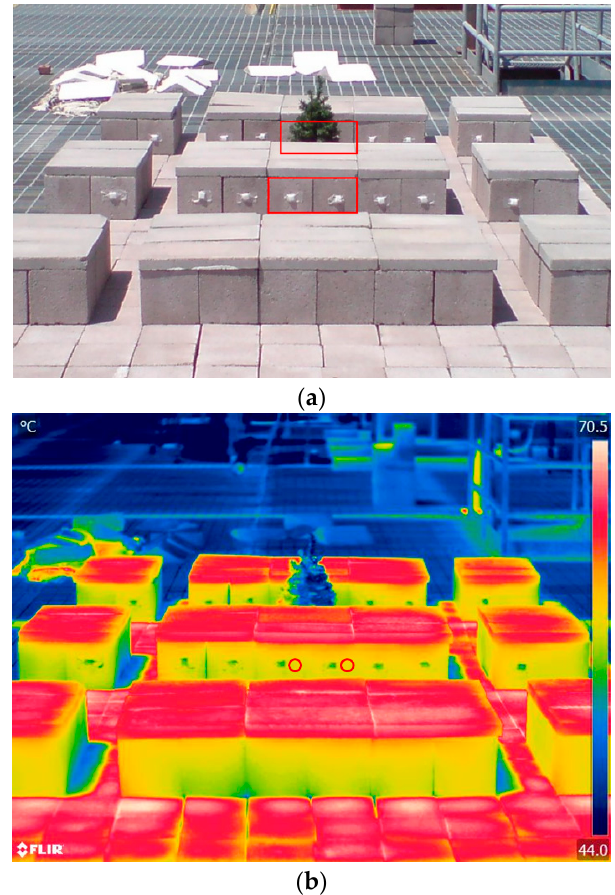
Figure 5. Thermal image and digital photo from FLIR P620 thermal camera (Taken at 13:59, 13 July). ( a ) Digital photo (red outline indicates iButtons that were used in the validation); ( b ) Thermal imagery (we extracted the surface temperatures from red circles for validation). Table 4. Temperature measurement errors (root mean squared error (RMSE) and mean absolute error (MAE)) between the thermal images and iButton loggers.